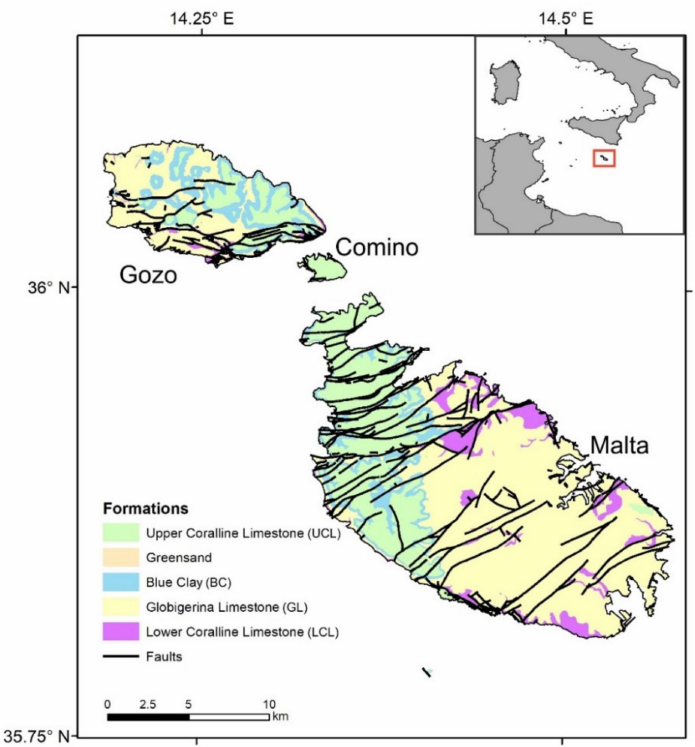
Figure 1. Location and geological map of the Maltese Islands